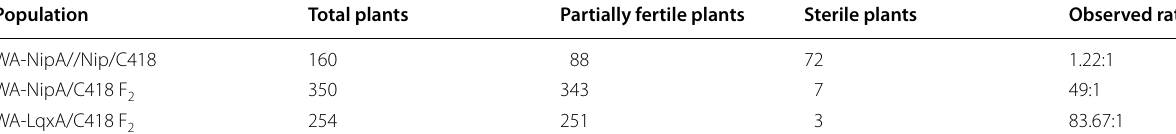
populations and three-cross F 2